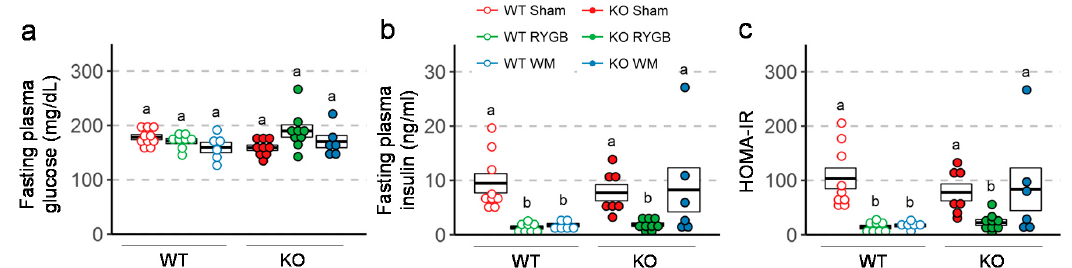
Figure 6. Effect of RYGB, sham surgery, or weight matching to RYGB by caloric restriction (WM) on fasting plasma glucose ( a ), fasting plasma insulin ( b ), and HOMA-IR ( c ), in Y2R-KO and WT mice, as measured at termination of the experiment. Data are presented as individual data points over a box showing means ± SEM. Data that do not share the same letters are significantly different from each other ( p < 0.05, pairwise t -tests with Benjamini–Hochberg correction, FDR = 0.05).